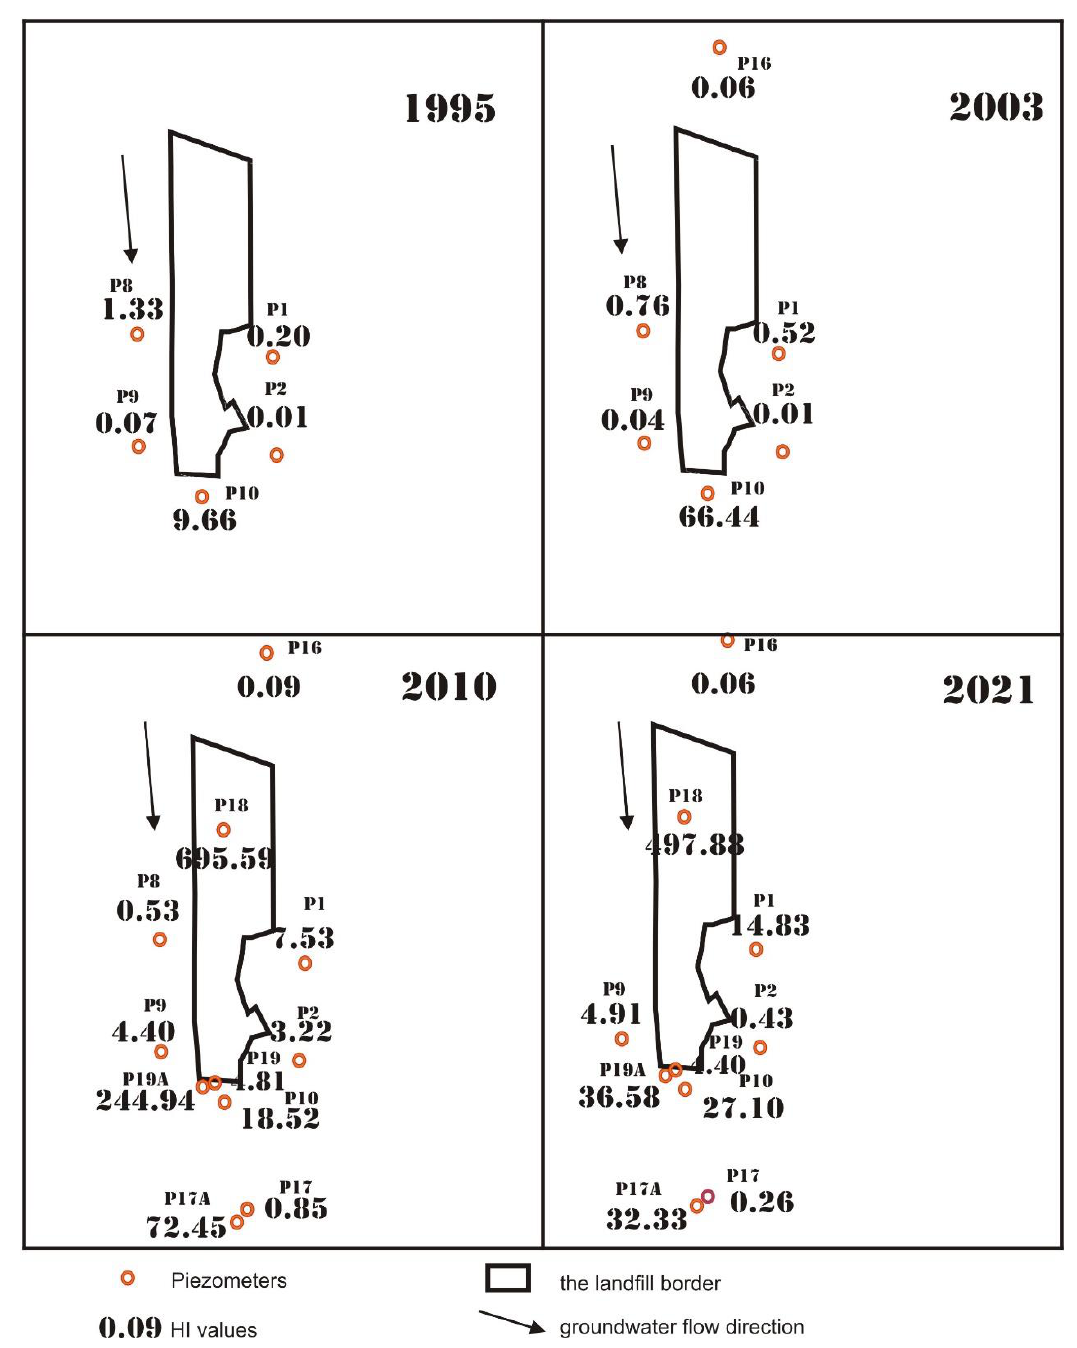
Figure 7. HI values in 1995, 2003, 2010, and